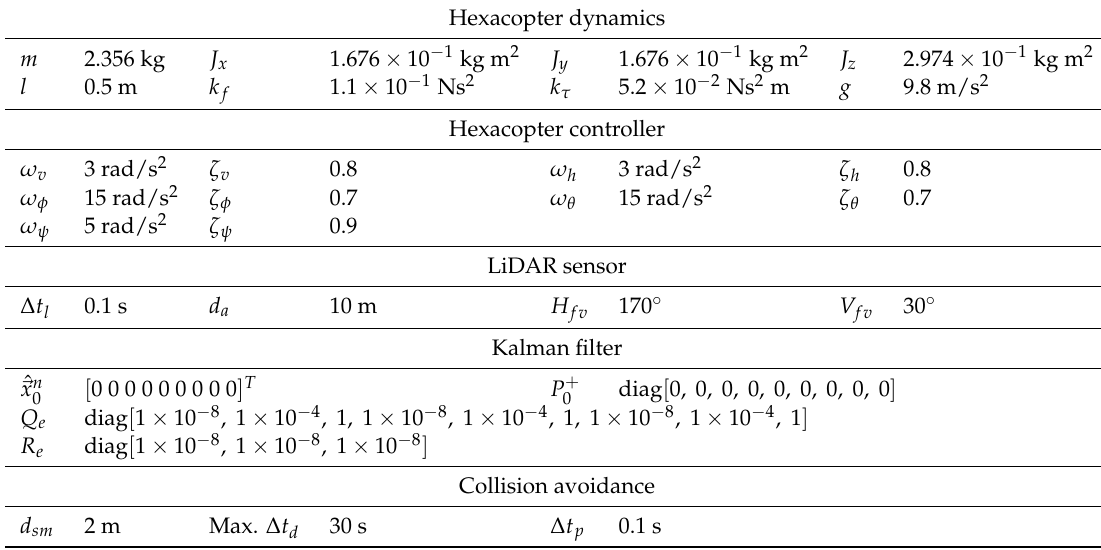
Table 1. Parameters of the hexacopter, Kalman filter, and collision avoidance used in numerical